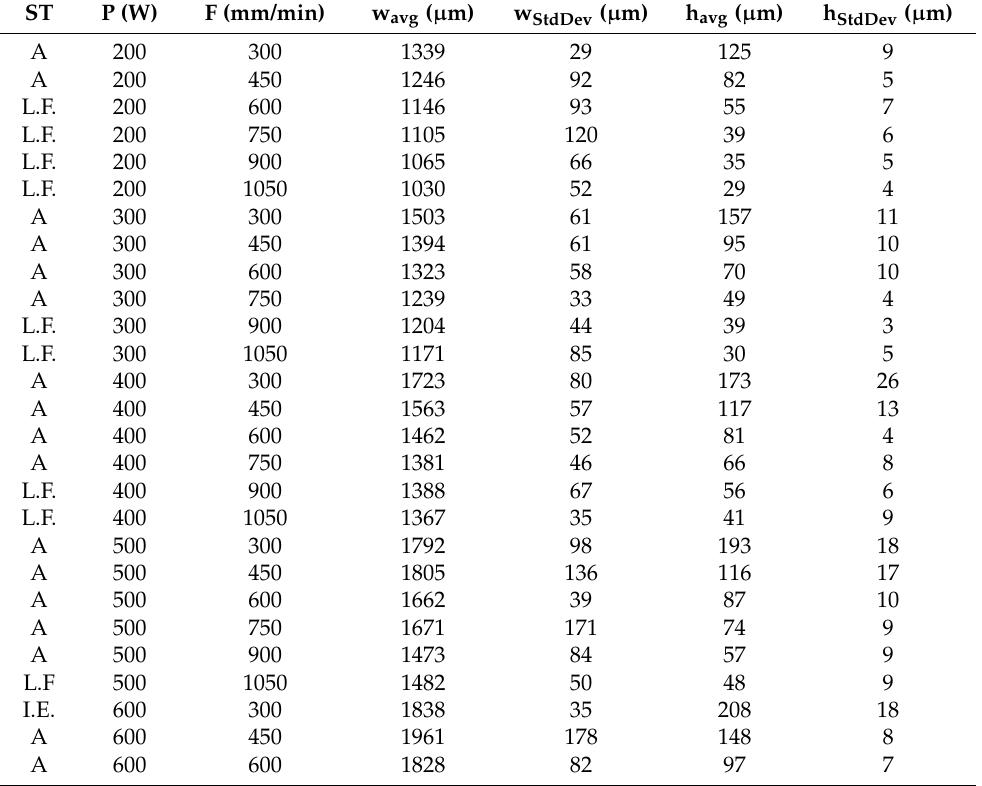
Table 3. Detected ST width and height (average and standard deviation). “A” = acceptable ST; “L.F.” = lack of fusion; “I.E.” = irregular ST edge. ST